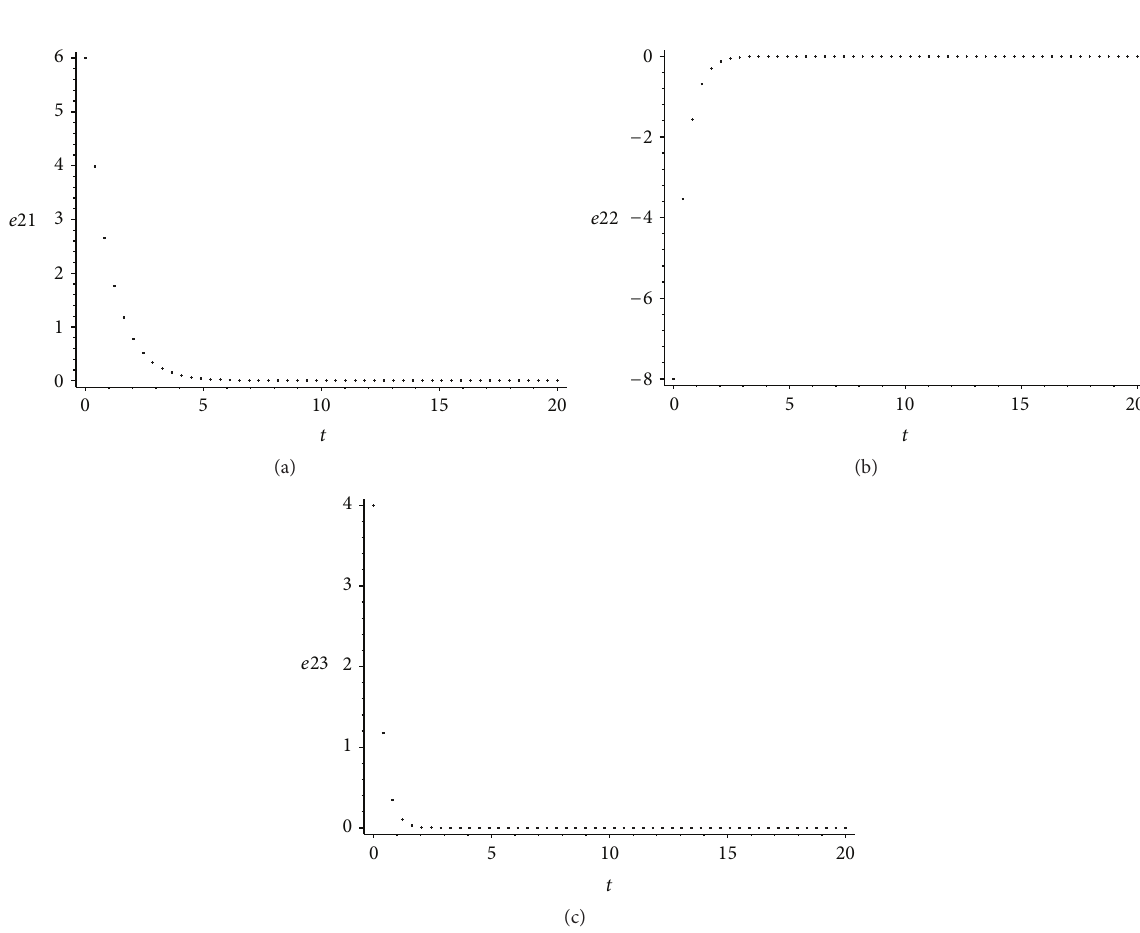
Figure 4: Network synchronization errors between node 1 and node